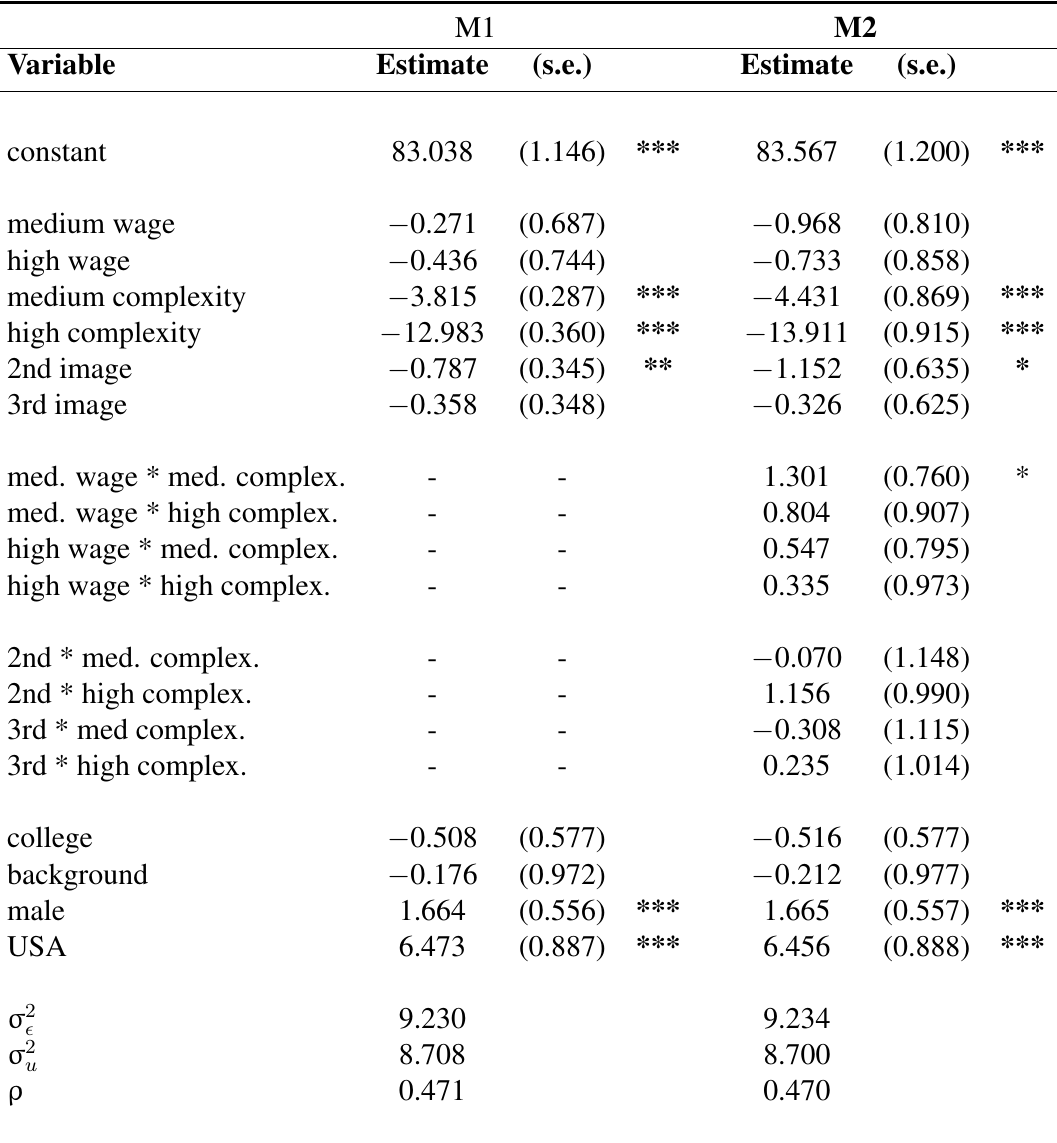
Table 3. Estimation